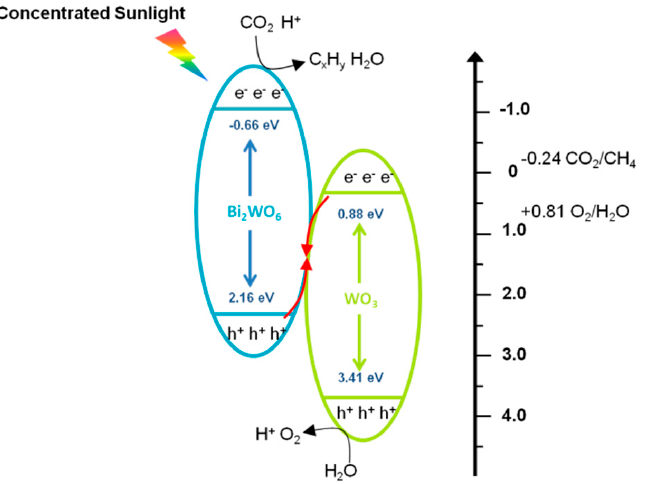
Scheme 1. Schematic diagram of CO 2 photoreduction with H 2 O in Bi 2 WO 6 /WO 3.